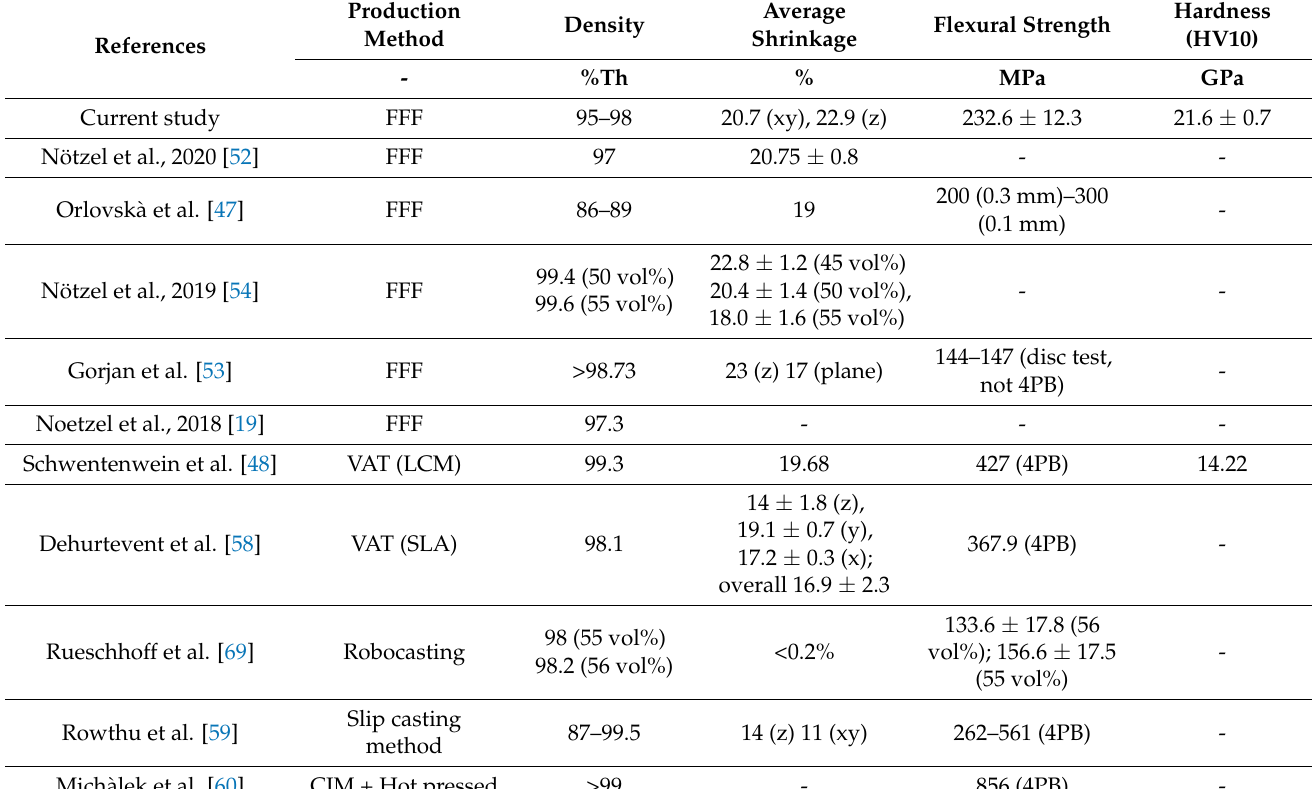
Table 4. Properties of alumina 3D-printed parts using different technologies compared to those in this